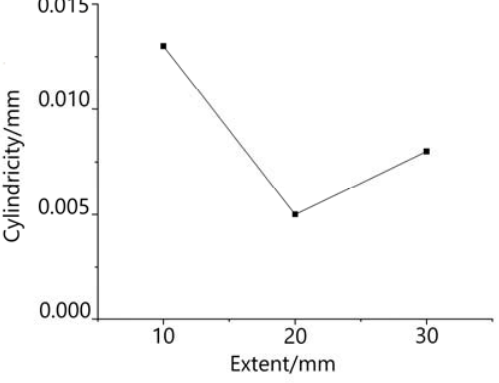
Figure 7. Cylindricity of different extensions.